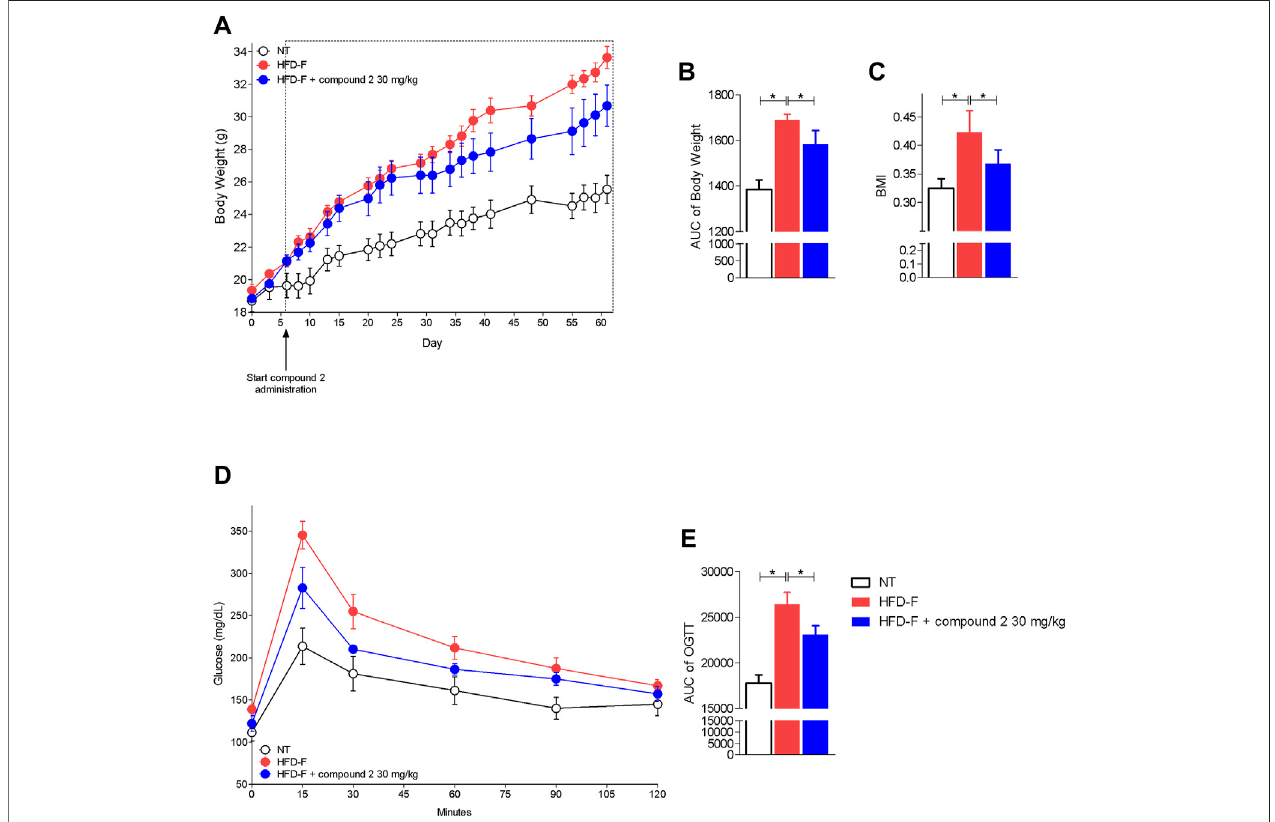
FIGURE5| Bene fi cialeffectsofcompound2onbodyweightgainandinsulinsensitivity.C57BL/6malemicewerefedahighfatdietandfructose(HFD-F)ornormal chow diet for 61 days. Fromday 7,compound 2 wasadministered by oralgavageat the dose of30 mg/kg/daily. (A) Changes in body weight (%) and (B) AUCs ofbody weight expressed in arbitrary units. (C) Body mass index (BMI) at the end of the experiment. (D) Glucose plasma levels in response to OGTT and (E) AUCs of glucose plasma levels expressed in arbitrary units. Results are the mean ± SEM of 5-7 mice per group; * p <